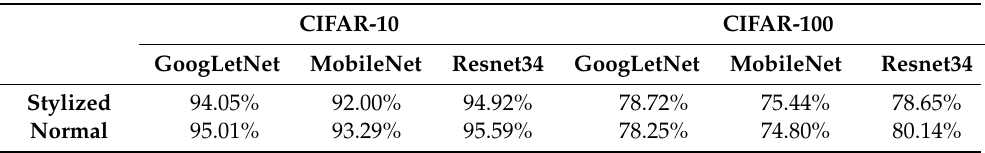
Figure 5. The adversarial accuracy rate of stylized pairing training style vs. standard stylized training without pairing loss where cyan lines denote models trained with standard stylized training and red lines denote models trained with stylized pairing. We show the perturbation strength measured by its L 2 norm ( left panel ) and L ∞ norm ( right panel ). Table 1. The accuracy rate of the models with stylized pairing training and normal training on the CIFAR-10 and CIFAR-100 datasets. Stylized denotes stylized pairing training and Normal refers to normal training without stylized images.